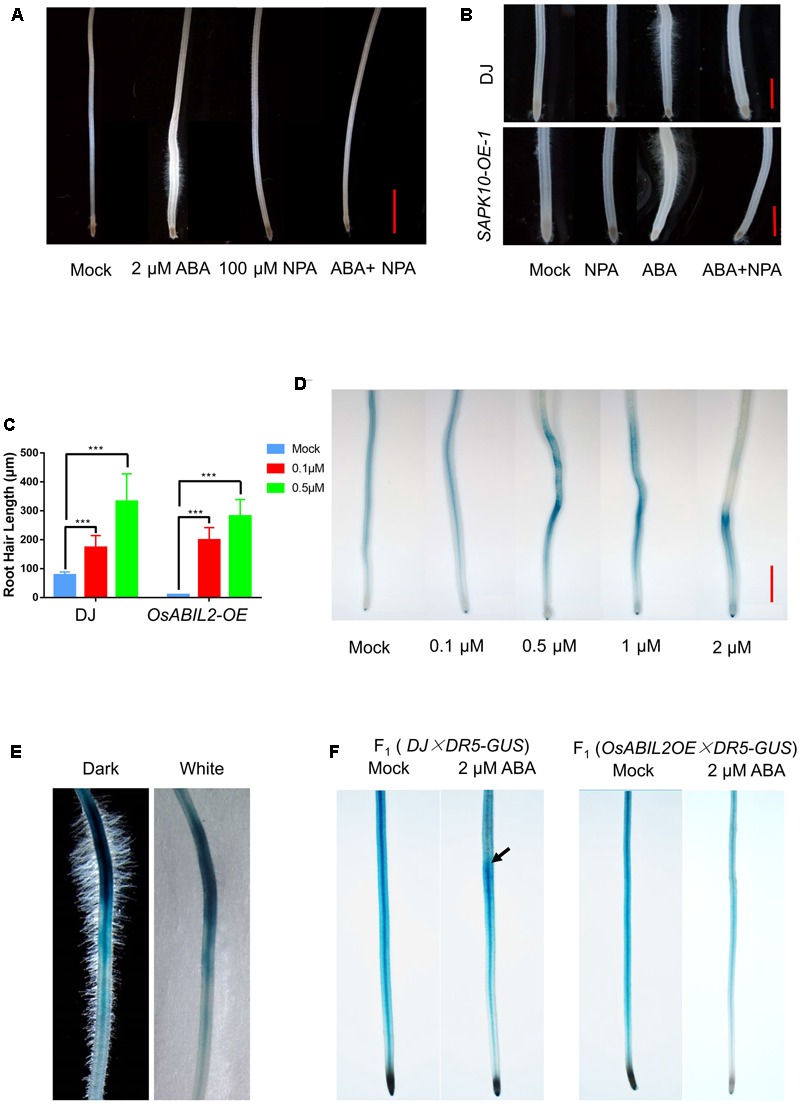
Auxin acts downstream of ABA signaling to promote root hair elongation. (A) Effect of the polar auxin transport inhibitor NPA on root hair elongation. Five-day-old seedlings were grown in solutions containing the indicated concentrations of ABA and/or NPA for 24 h. Scale bar = 2 mm. (B) Root hair elongation of the SAPK10-OE plants in response to ABA and NPA treatments. Five-day-old seedlings were grown in solutions containing the indicated concentrations of ABA and/or NPA for 24 h. Scale bar = 1 mm. (C) Quantification of root hair length of the OsABIL2-OE plants and wild type in response to the exogenous auxin. Five-day-old seedlings were grown in solutions containing 0, 0.1, or 0.5 μM NAA for 24 h. Data are means ± SD. (D) ABA affects the concentration and distribution of auxin indicated by the DR5-GUS reporter. Five-day-old seedlings were grown in solutions containing different concentrations of ABA for 24 h. Scale bar = 2 mm. (E) Close-up view of the long root hair zone of the DR5-GUS line treated with 0.5 μM ABA for 24 h. Images with dark (left) and white (right) backgrounds are shown. (F) The GUS activity in the F1 seedlings in response to treatment with 2 μM ABA for 24 h. Wild type (DJ) and the OsABIL2-OE plants were crossed with the DR5-GUS line (Zhonghua11 background, ). Five-day-old seedlings were used. Black arrows indicate the accumulation of DR5-GUS in the long root hair zone.